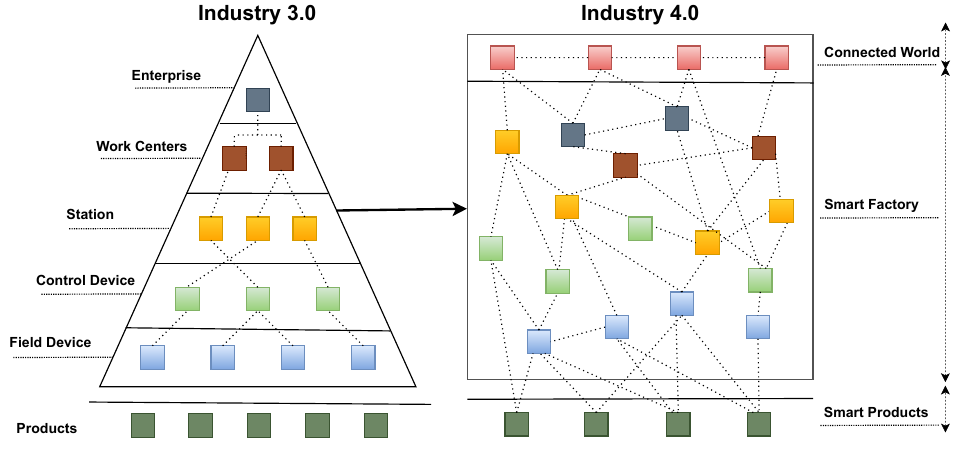
Figure 2. Industry 3.0 vs Industry 4.0 (adapted from [32]).